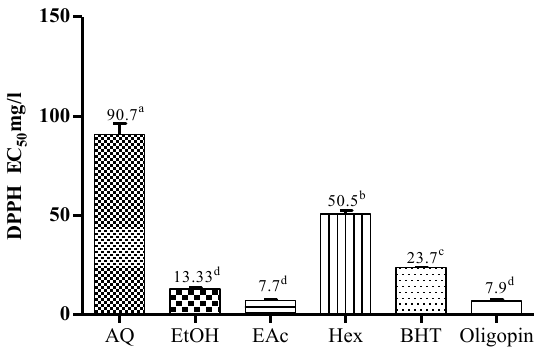
Figure 1. Radical scavenging activities of M. arboreus extracts/fractions determined by the reduction of DPPH free radical. The extracts having the same letter present no significant differences ( p < 0.05) according to Tukey statistical test.